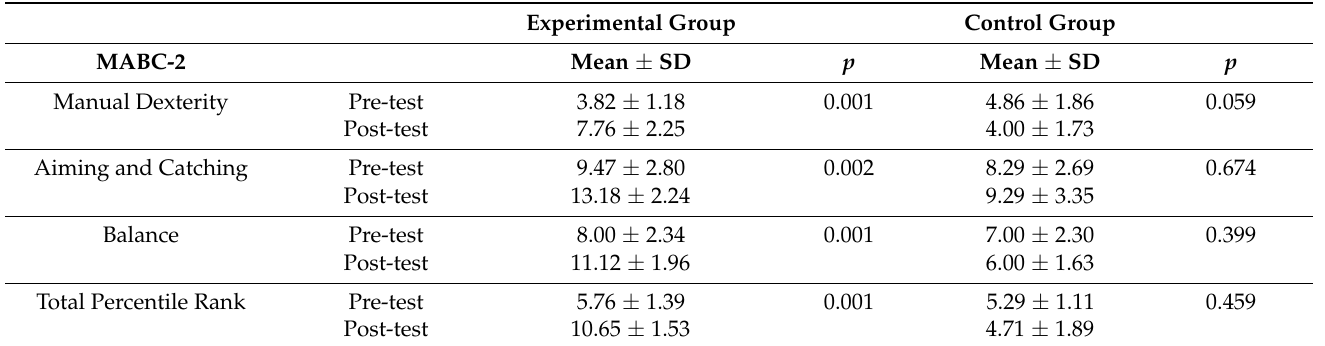
Table 5. Experimental and Control groups. Results from MABC-2 domains at pre-and